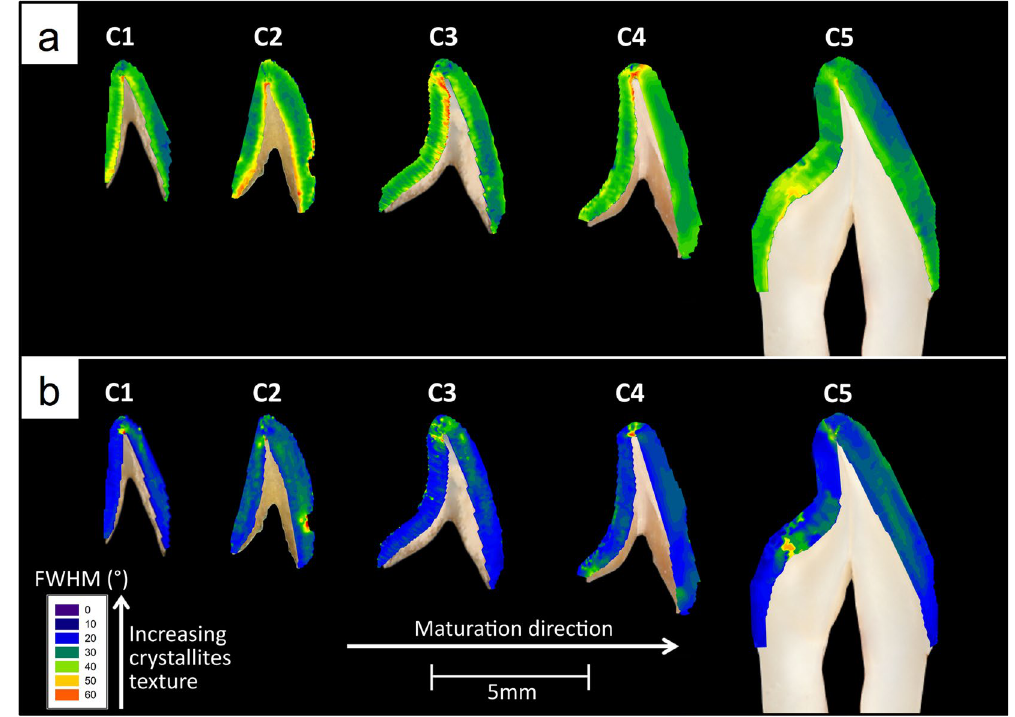
Figure 5. Texture magnitude distribution of crystallites from the ( a ) first and ( b ) second orientation populations in central incisal enamel at various development stages. For each tooth section labial is on the right hand